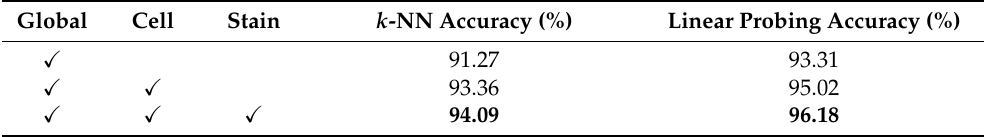
Table 9. Ablation experiments of HistoSSL. We report the accuracies of both k -NN and linear probing under combinations of global-level, cell-level, and stain-level feature correspondence. The backbone was